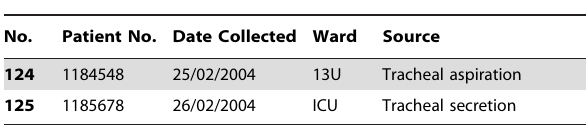
Table 2. Strain number, patient number, ward, source and date of isolation of 50 Acinetobacter spp.